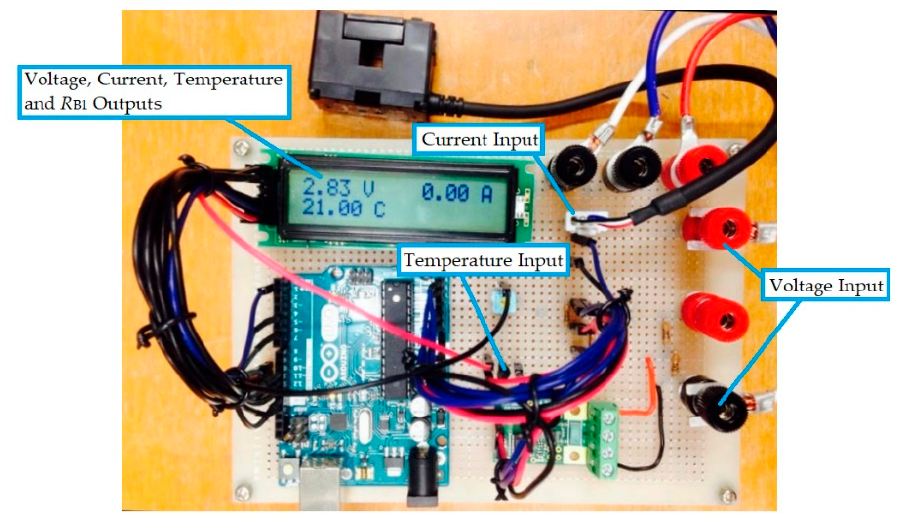
Figure 15. Deterioration diagnosis circuit.